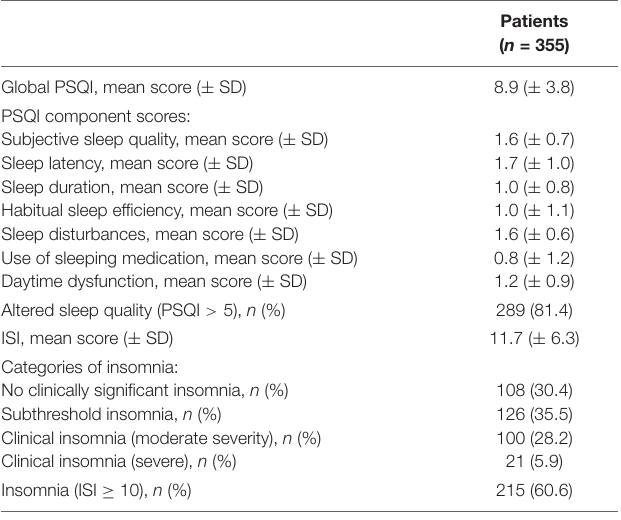
TABLE 2 | Detailed characteristics of subjective sleep in the overall population.